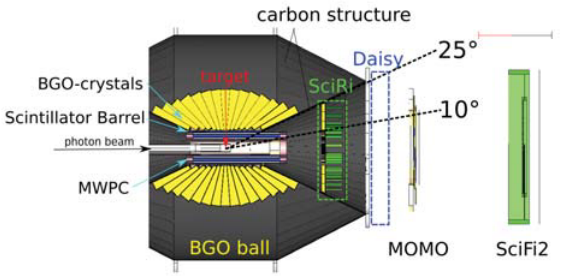
Figure 4. Slice view of the central detector consisting of the segmented BGO Rugby Ball, cylindrical inner scintillator barrel and MWPC, and the SciRi scintillator ring detector in forward direction. Also depicted are MOMO and SciFi, the front track- ing fibre detectors of the forward spectrometer and the MRPC detector under construction.